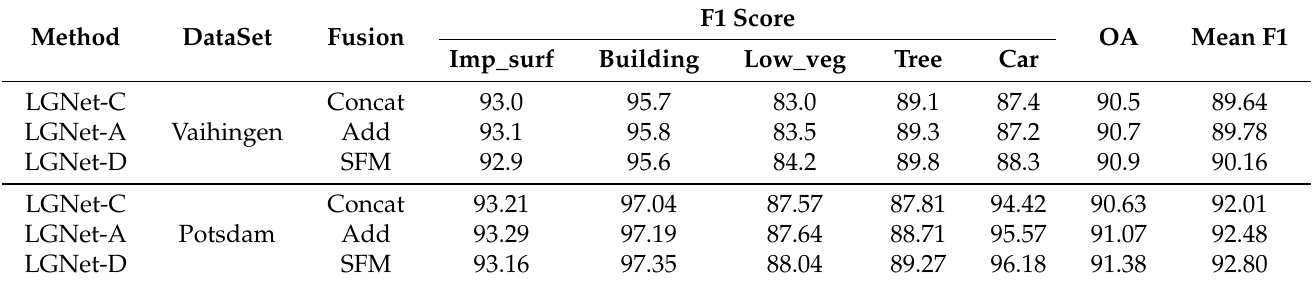
Table 2. The effect of the dual-source fusion network on the ISPRS Vaihingen and Potsdam datasets.